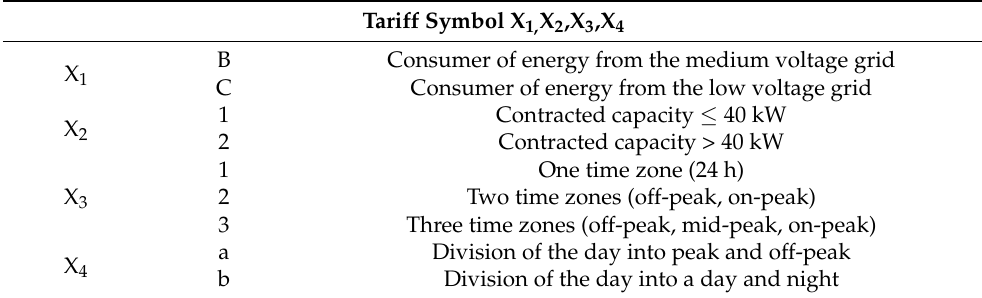
Table 1. Composition of tariff groups according to Tariff Regulation Article 6, Act